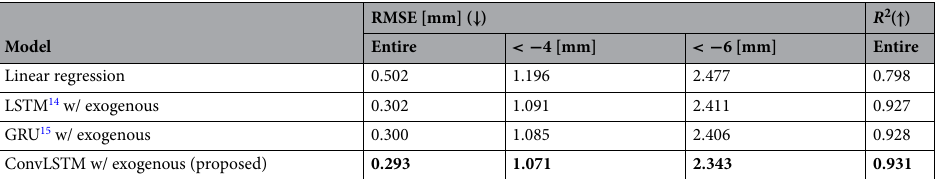
data and data with the evaluation threshold levels α = − 4, − 6 [mm]. Significant values are in bold.